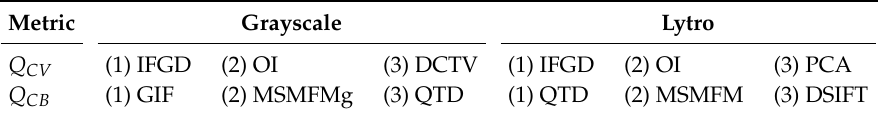
Table 6. Summary of performance evaluation using human perception based metrics. For each metric, the numbers (1), (2), and (3) show the three best performing algorithms, respectively. Metric Grayscale Lytro